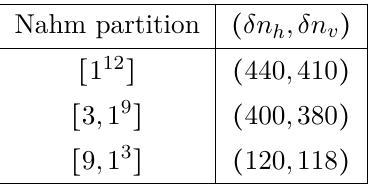
Table 8. Table containing the data defining the punctures for the 4d E 8 × E 8